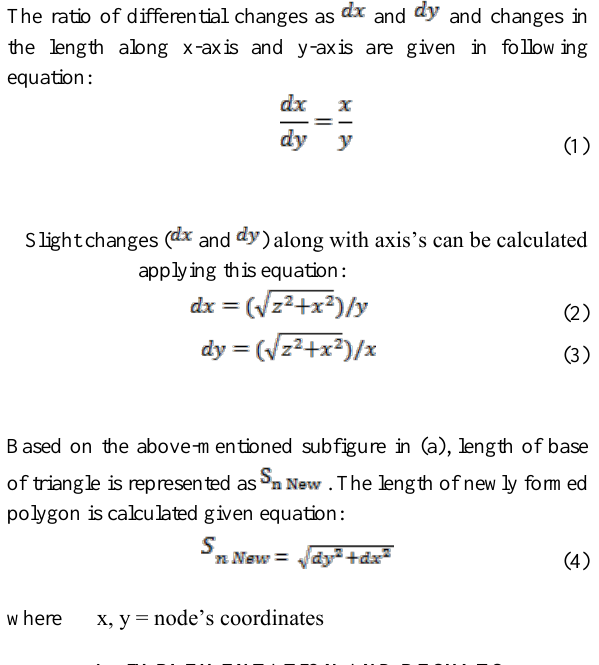
Figure 4. Simplification of three jointly attached edges of a polygon: Reduction of shortest edges based on differential changes shown in (b) and simplified polygons as final result in (c).